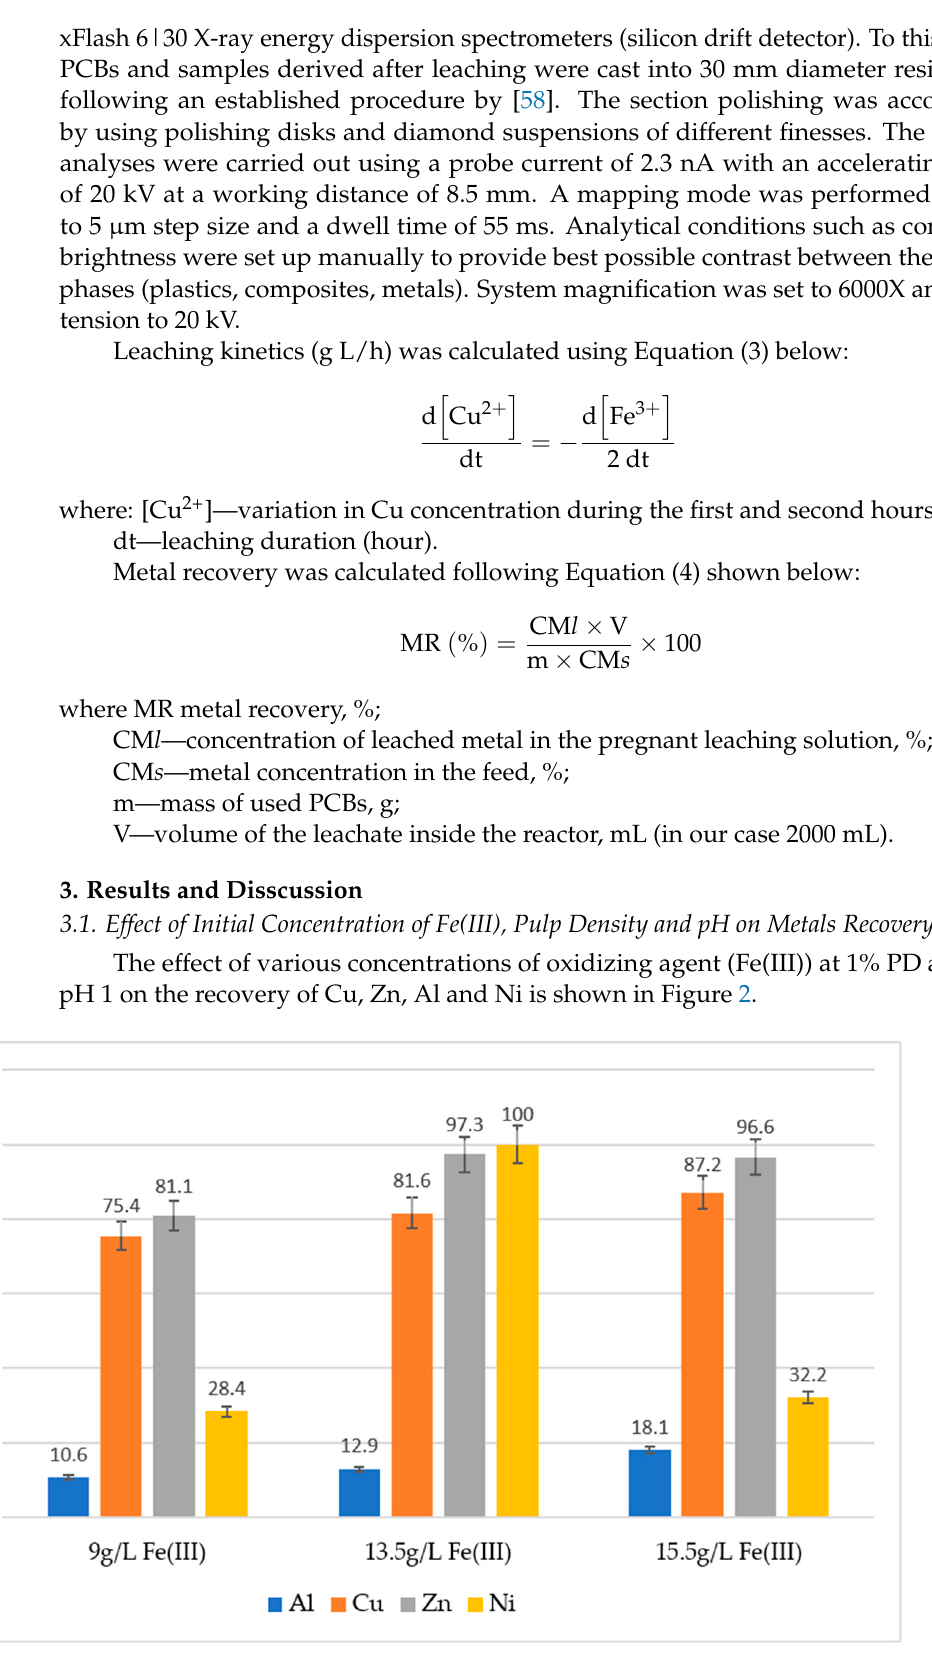
Figure 2. Recovery of metals from PCBs at various concentrations of biogenic Fe 3+ (PD 1%; initial pH 1–1.1; 40 ◦ C; air 1 lpm; 600 rpm; duration 24